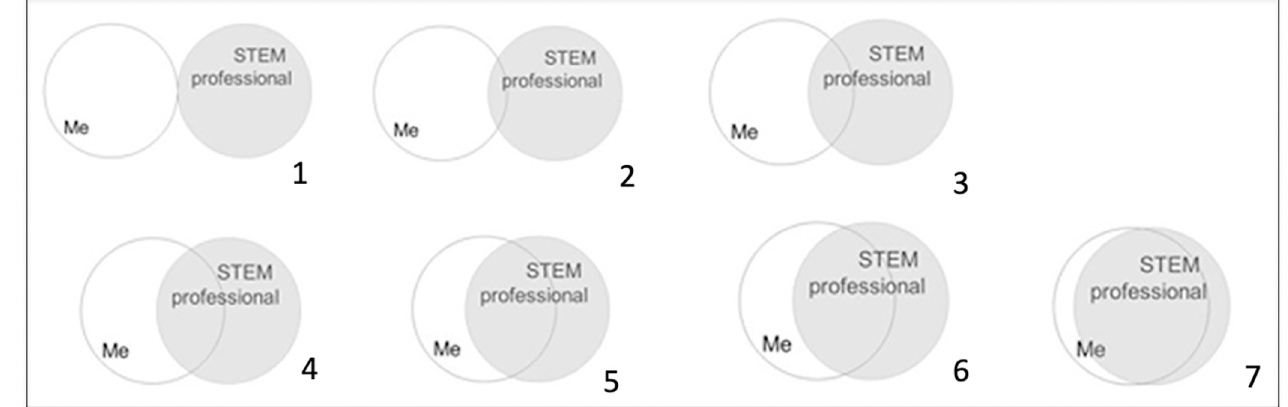
Fig 2. Single item measure of STEM identity used in PARE-Seq surveys. Students were asked: Please select the picture above that best describes the current overlap of how you see yourself and what your image of a STEM professional is (McDonald et al., 2019).